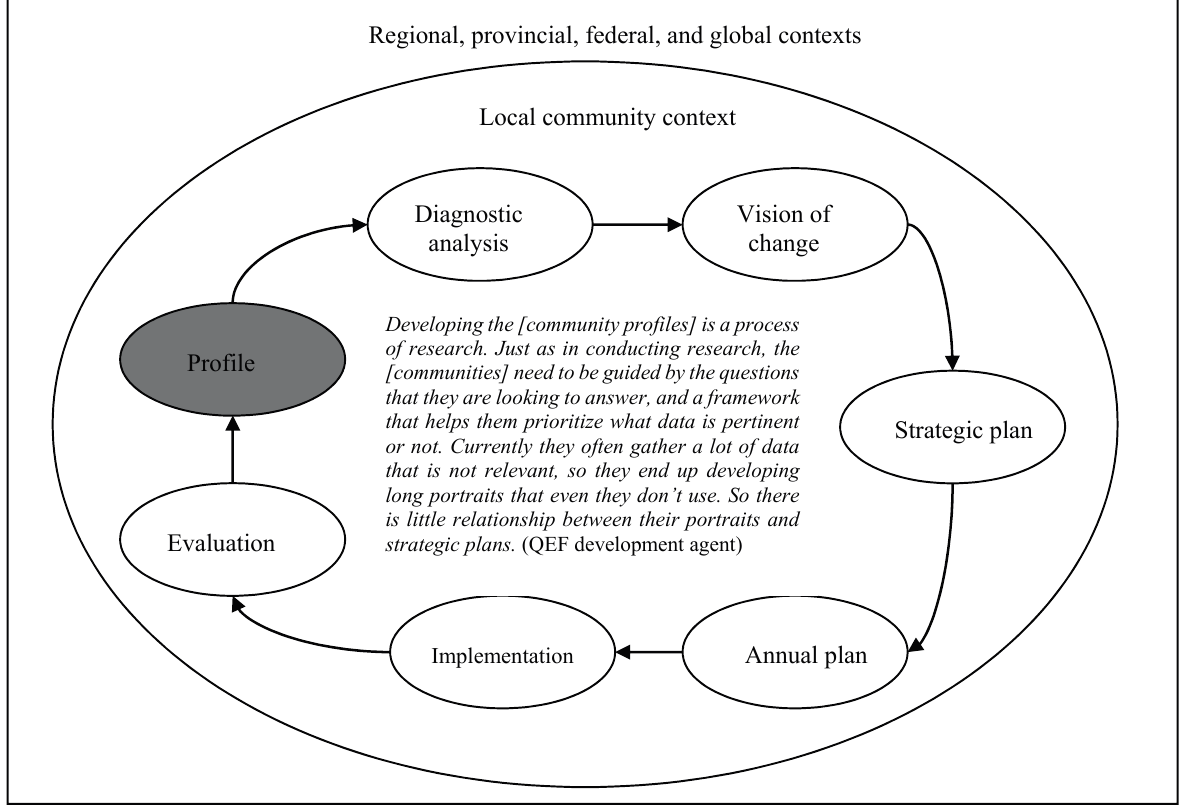
Figure 2. The embeddednes of community mobilization